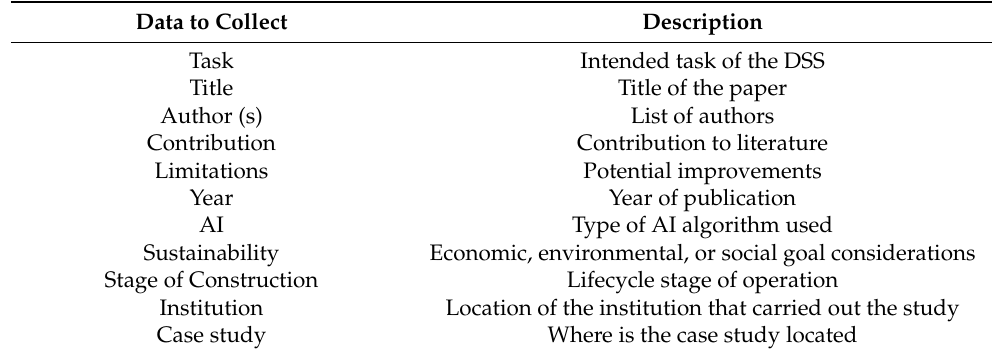
Table 1. A table describing the assessment criteria for this literature review. Data to